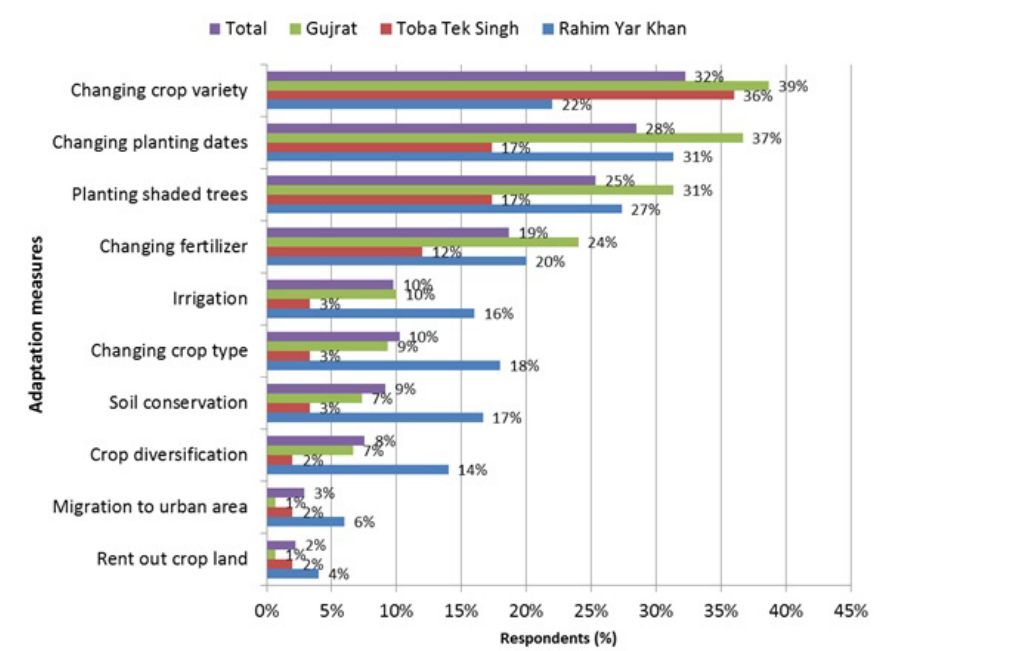
Figure 5. Adaptation measures adopted by farmers across three study areas in Punjab, Pakistan.